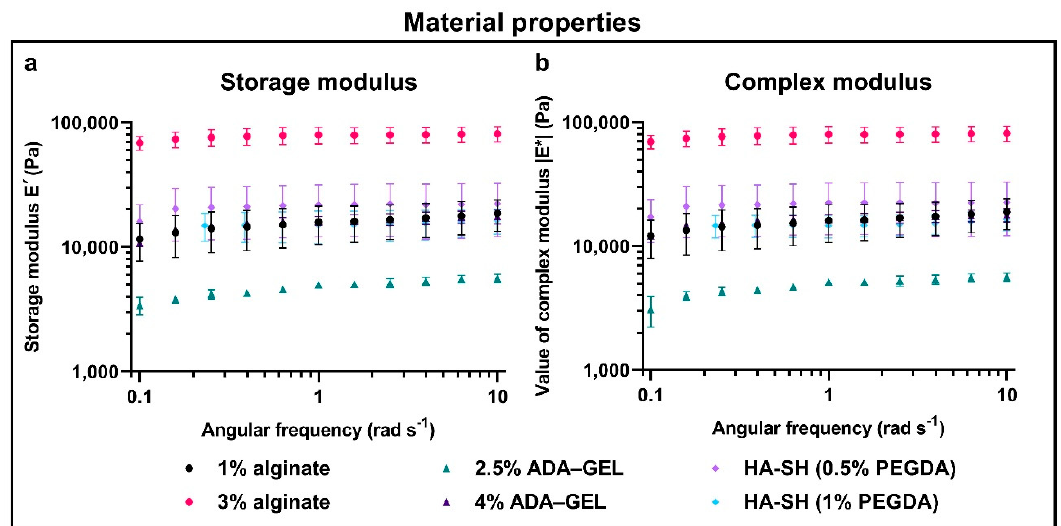
Figure 1. Phase contrast images of cell lines in Matrigel (top) and agar (bottom); all cell lines (MDA-MB-231, MCF-7, Mel Im, and MV3) were able to form multicellular colonies from single cells in both matrices; scale bar = 100 µ m.